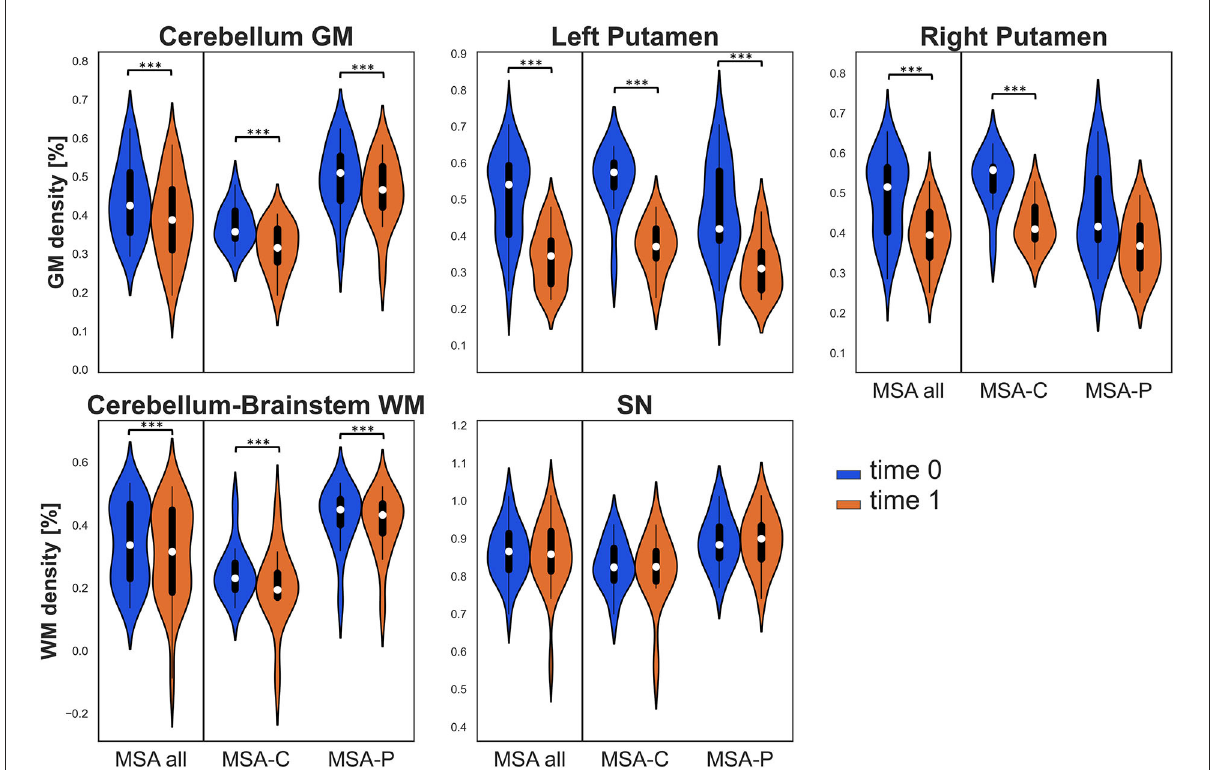
FIGURE1 Violin plots describing distributions of regional tissue density in all the considered regions of interest (ROIs). The panels of the first row illustrate gray matter (GM) density in the clusters of the cerebellum and bilateral putamina, while the panels of the second row illustrate white matter (WM) density in the cerebellum-brainstem cluster and in the bilateral substantia nigra (SN). Values at baseline (t0) are in blue, while values at follow-up (t1) are in orange for the entire multiple system atrophy (MSA) group (MSA all) and for both MSA subgroups. Significant differences are indicated with asterisks. *** p <